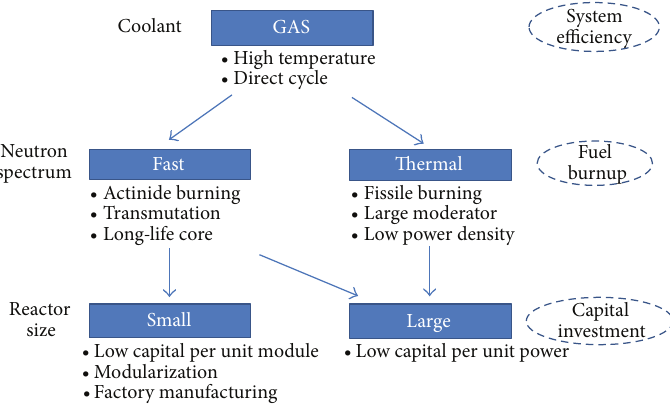
Figure 1: Design choices and economic factors.